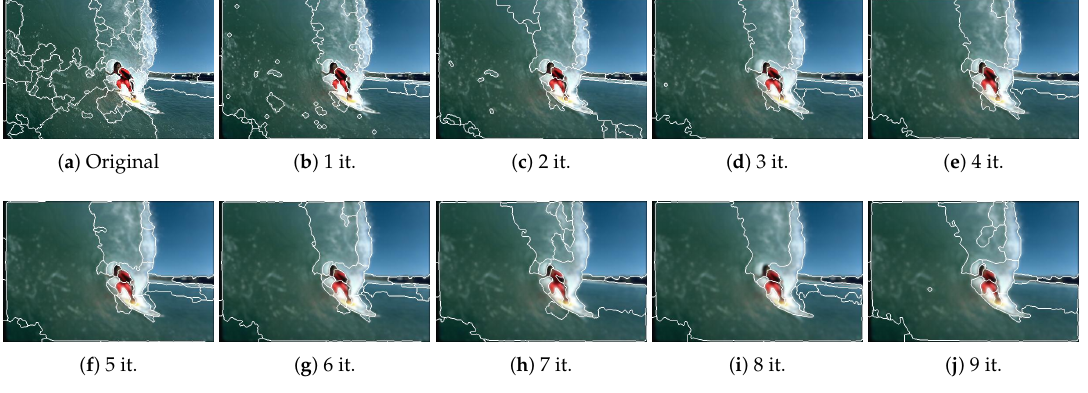
Figure 10. JSEG segmentation results for image 300091—the original and after applying the Gaussian filter for the specified number of